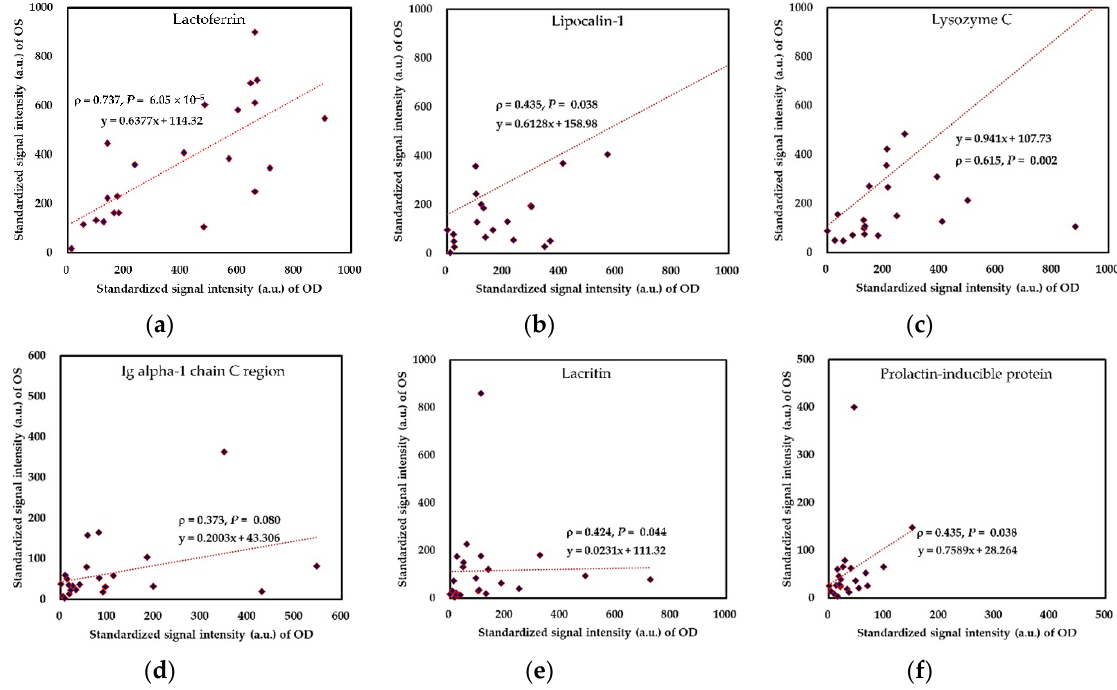
Figure 4. Binocular association of lactoferrin-corrected standardized signals for six always presented molecules in tear samples of dry eye patients. ( a ) lactoferrin; ( b ) lipocalin-1; ( c ) lysozyme C ( d ) immunoglobulin alpha-1 chain C region; ( e ) lacritin; and ( f ) prolactin-inducible protein. Abbreviation: Ig, immunoglobulin.